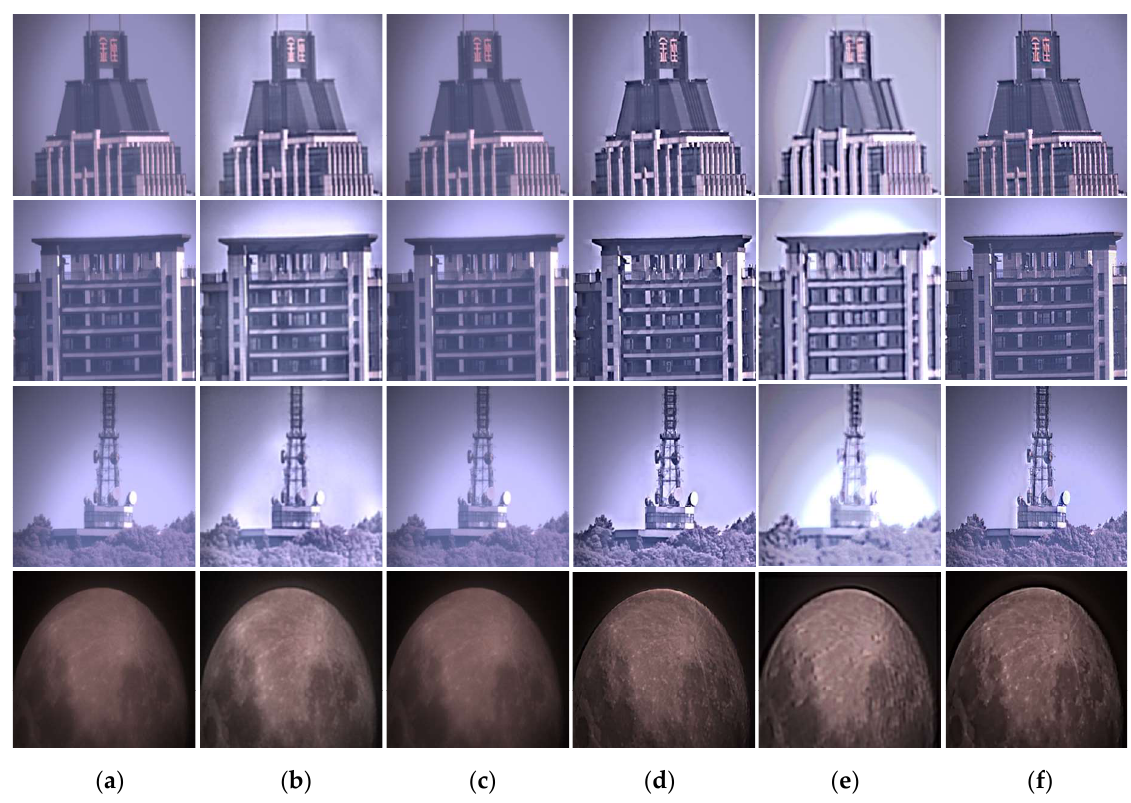
Figure 10. Restored results of turbulence distorted images taken by the Cassegrain optical observation system. ( a ) Degraded image; ( b ) CLEAR; ( c ) SGL; ( d ) IBD; ( e ) Gao et al.; ( f ) DTL (ours).